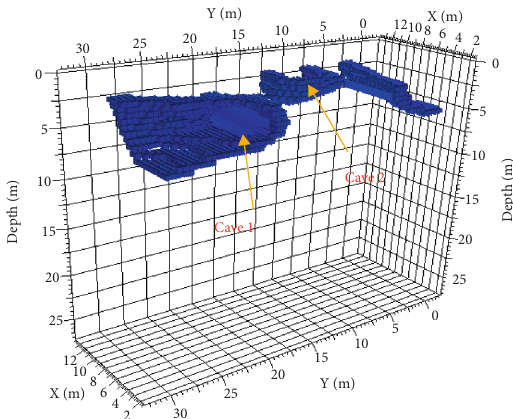
Figure 13: Locations of the karst caves in the west side of the foundation pit.